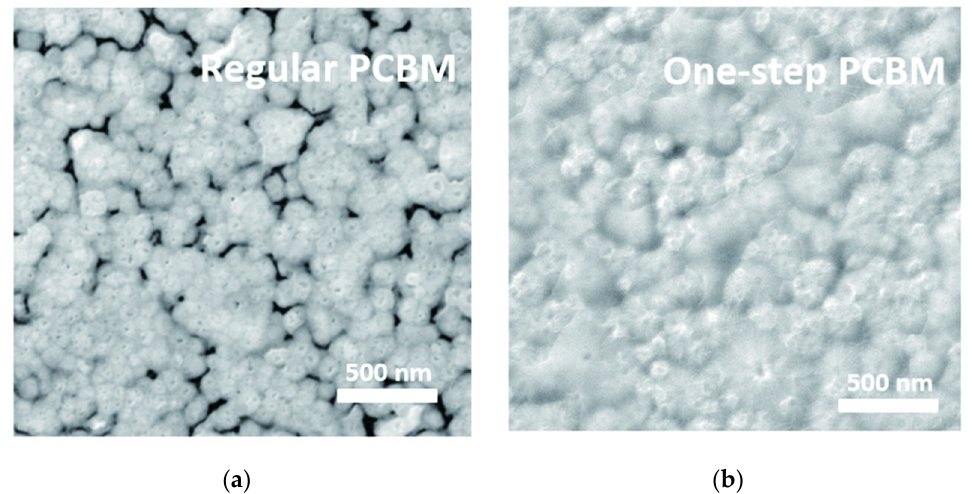
Figure 3. Top-view SEM images for (BA) 2 (MA) 3 Pb 4 I 13 deposited with ( a ) regular and ( b ) one-step method.